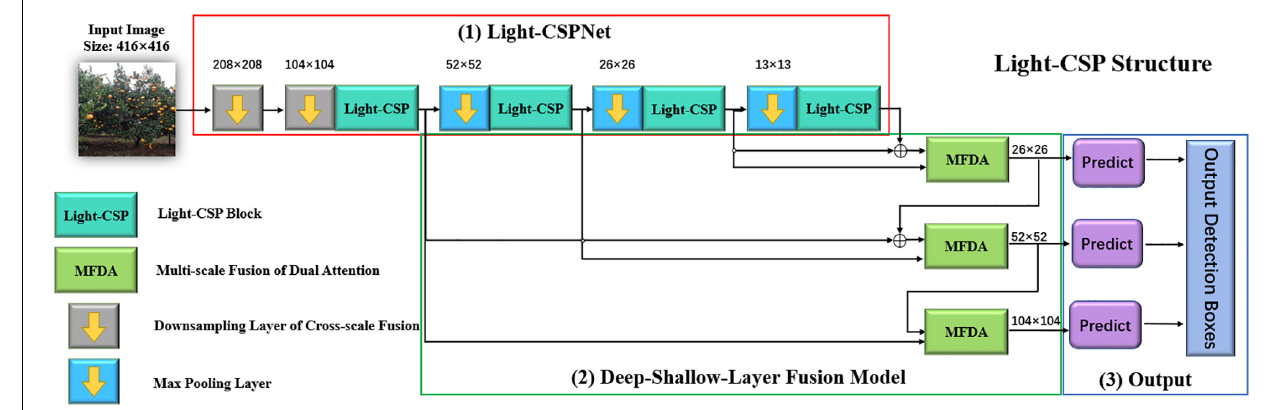
FIGURE 1 | General architecture of the algorithm.